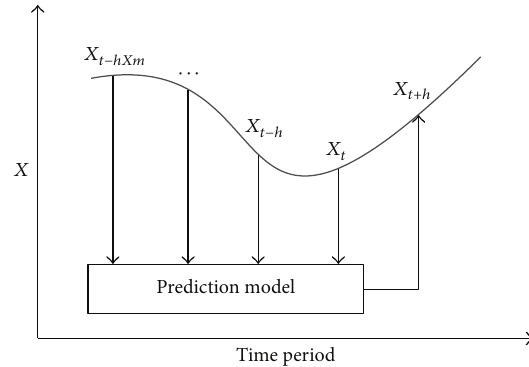
Figure 1: Time series prediction